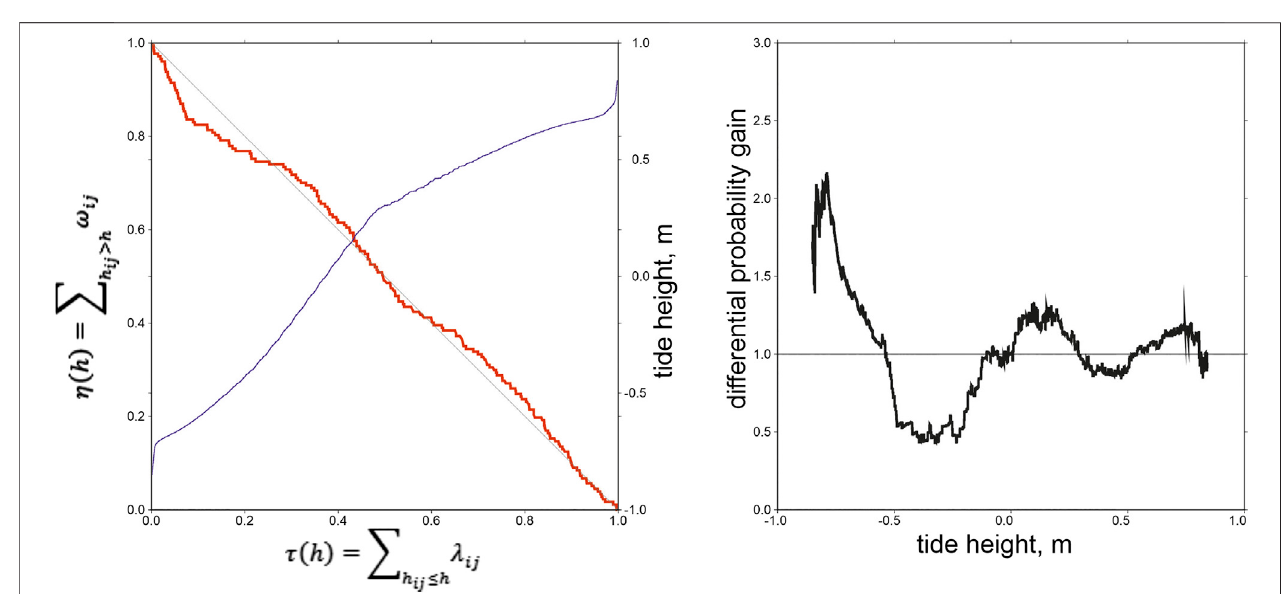
FIGURE 5 | An example of the differential probability gain function. Aftershocks of the M (cid:1) 6.3 earthquake of June 21, 1992 in New Zealand. A) Error diagram (red line), η ( h ) (cid:1) η ( τ ( h )) , with τ ( h ) (cid:1)